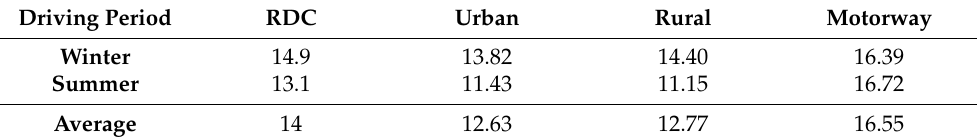
Table 3. Summary of vehicle energy consumption estimated on 100 km